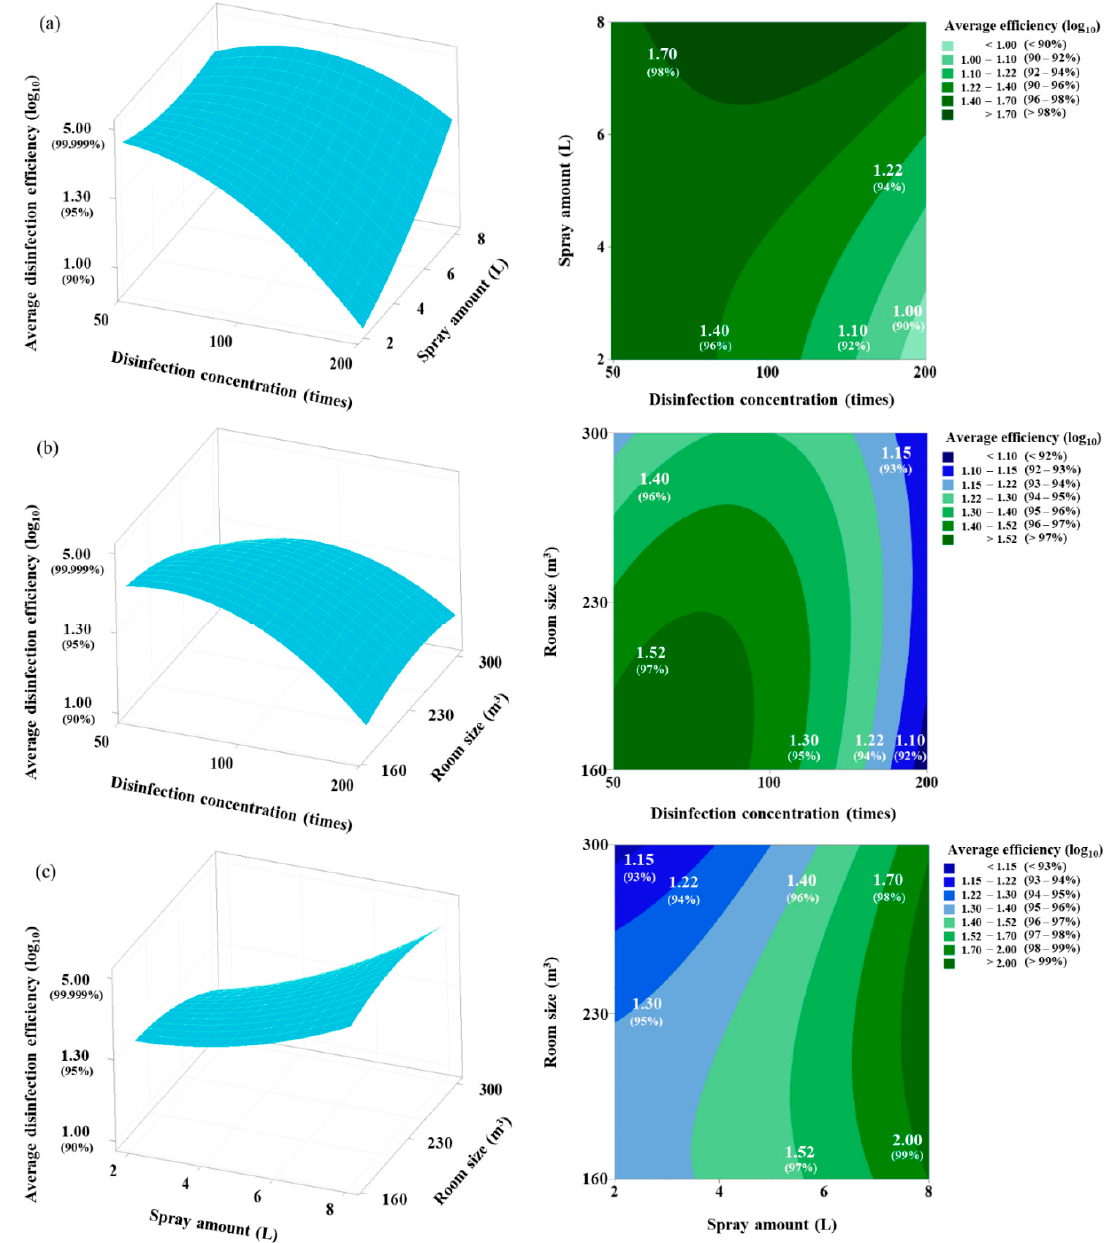
Figure 6. Response surface plots presenting the interaction effects of three variables on the average total bacteria disinfection efficiency: ( a ) surface plot showing the effect of disinfectant concentration and spray amount on the average disinfection efficiency, ( b ) surface plot showing the effect of disinfectant concentration and room size on the average disinfection efficiency, and ( c ) surface plot showing the effect of spray amount and room size on the average disinfection efficiency.